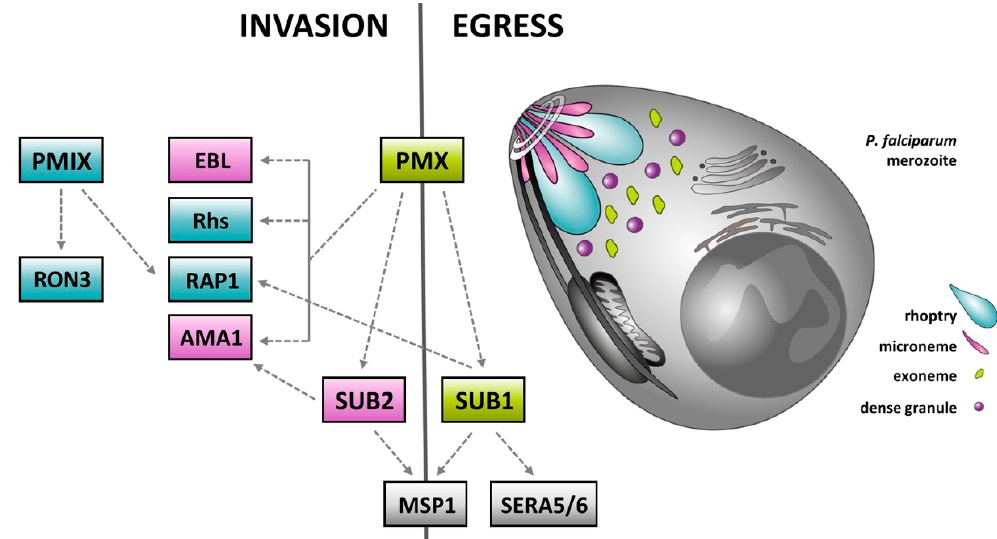
Figure 2. Proteolytic events associated with egress and invasion of red blood cells by P. falciparum [47–50]. Clade C aspartyl protease PMX has been confirmed as the master activating protease of the whole apical complex associated proteolytic system. The central role is maintained by subtilisin-like proteases (SUB1, SUB2), both activated by PMX. SUB1 is released into the parasitophorous vacuole (PV) where it triggers effector proteins such as serine repeat antigens 5 and 6 (SERA5/6)—a pseudoprotease and a cysteine protease regulating parasite egress. Moreover, activity of SERA5/6 and the interactions between SUB1-processed merozoite surface protein 1 (MSP1) and the spectrin network of the erythrocyte cytoskeleton facilitate host erythrocyte rupture during parasite egress. PMX also regulates the process of invasion of naïve erythrocytes by direct or SUB2-mediated processing of merozoite adhesins such as the apical membrane antigen 1 (AMA1). PfPMX- activated SUB2 also contributes to the process of invasion by shedding merozoite surface protein complexes, including MSP1, and sealing of the host erythrocytes upon invasion. Among recently identified substrates of PMX belong erythrocyte binding-like proteins (EBL) and reticulocytes-binding protein homologs (Rhs). They participate in invasion of erythrocytes while initiating changes in the erythrocyte membrane leading to its increased susceptibility to deformation. PMIX is believed to play a role during the invasion by specific processing of several rhoptry proteins. PMIX processes the rhoptry-associated protein 1 (RAP1), which is involved in creation of the parasithophorous vacuole (PV) upon erythrocyte invasion. PMIX also processes the rhoptry neck protein 3 (RON3), that localizes to the membrane of the newly emerging PV and is believed to facilitate import/export of nutrients and effector proteins between the PV and erythrocyte cytoplasm.